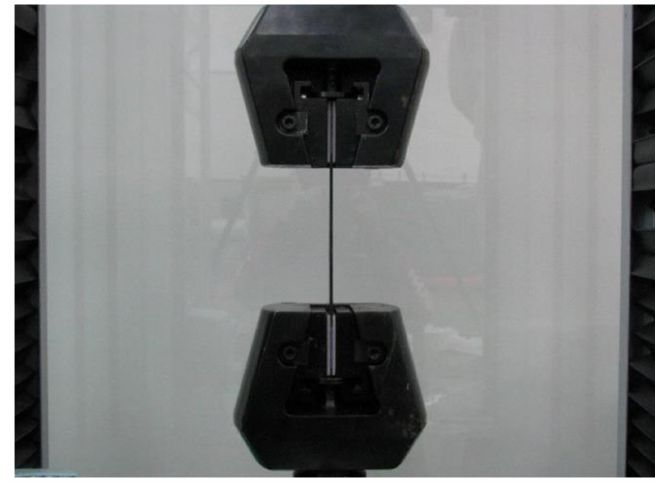
Figure 1. Tensile test of the manufactured specimen.